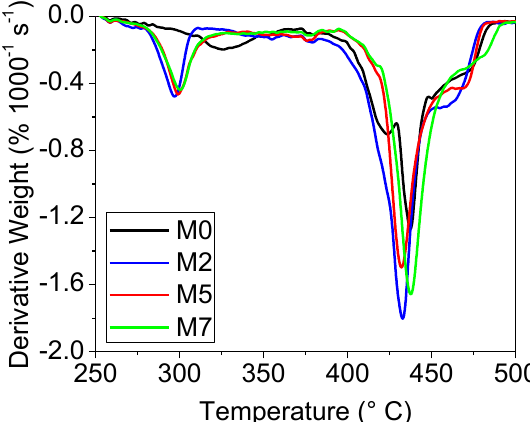
Figure 7. Derivative thermal gravimetric analysis (TGA) curves of the membrane samples.